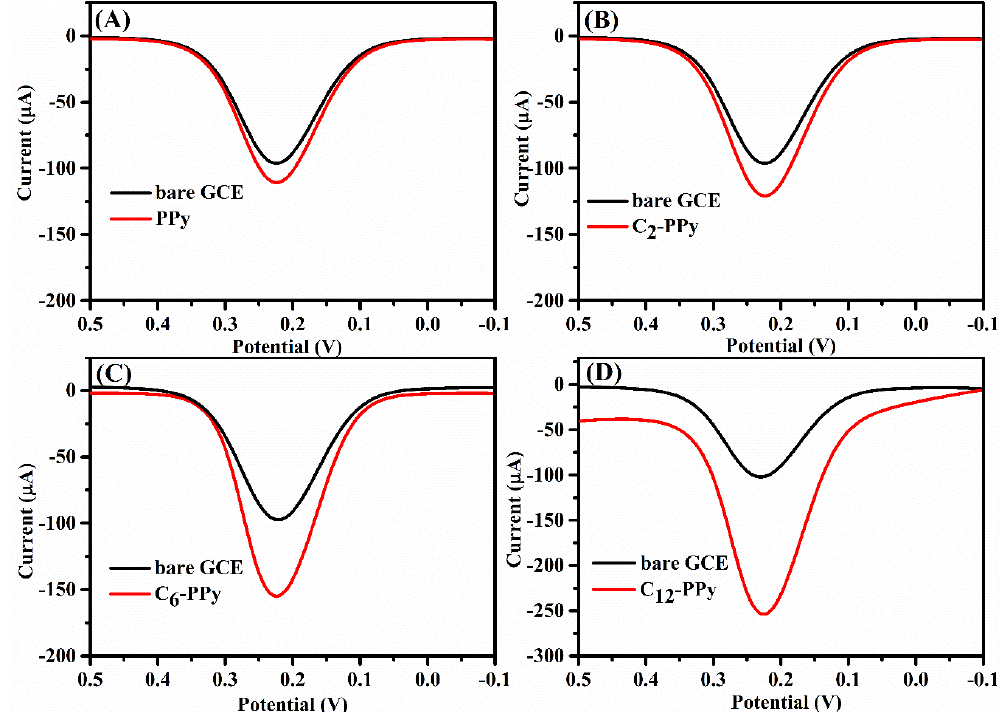
Figure 4. Comparison of DPV response of bare GCE and modified GCE ( A ) PPy/GCE; ( B ) C 2 -PPy/GCE; ( C ) C 6 -PPy/GCE and ( D ) C 12 -PPy/GCE in 0.01 M PBS containing 5 mM Fe[(CN) 6 ] 3 − /4 − and 0.1 M KCl (pH 7.0).